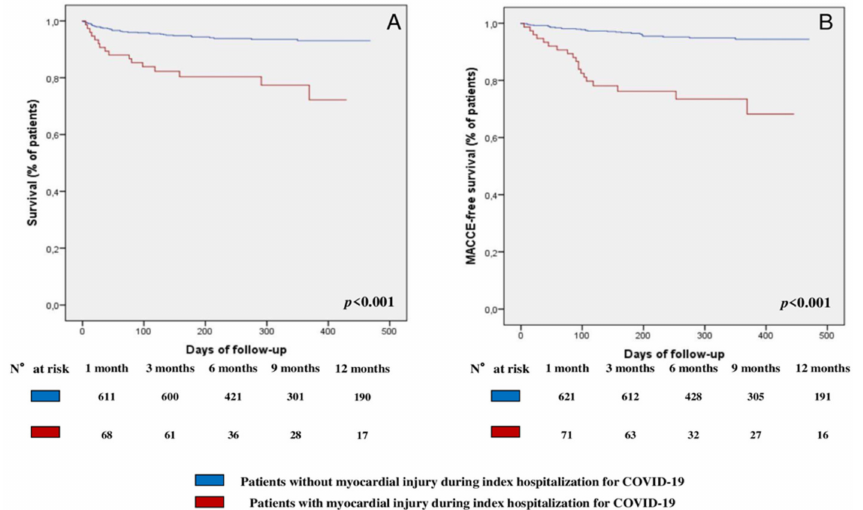
Figure 2. Survival analysis: ( A ) Survival Kaplan–Meier curve for all-cause mortality, according to the presence or absence of myocardial injury during the index hospitalization for COVID-19. ( B ) Survival Kaplan–Meier curve for MACCE, according to the presence or absence of myocardial injury during the index hospitalization for COVID-19. Abbreviations: MACCE—major adverse cardiovascular and cerebrovascular event; COVID-19—Coronavirus